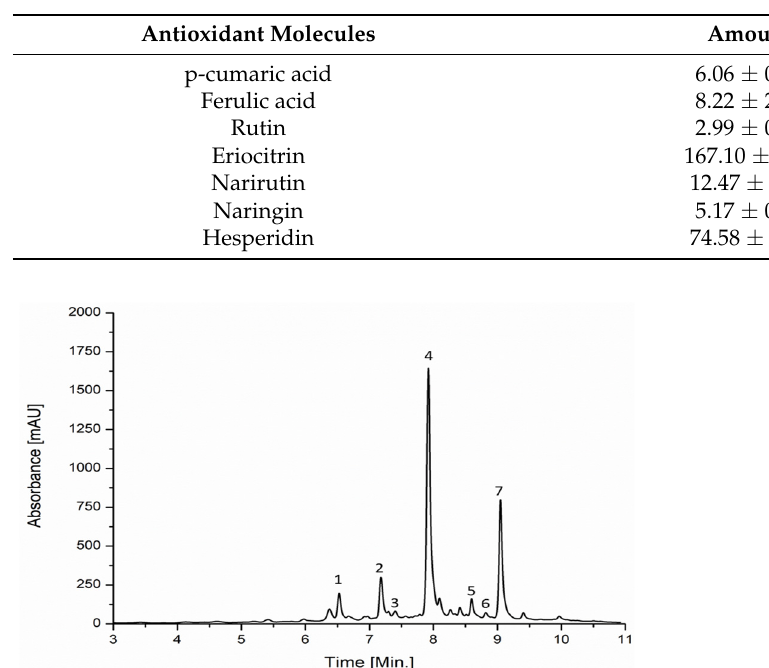
Table 3. Antioxidant characterization of the extract analyzed by UHPLC (mg/kg).